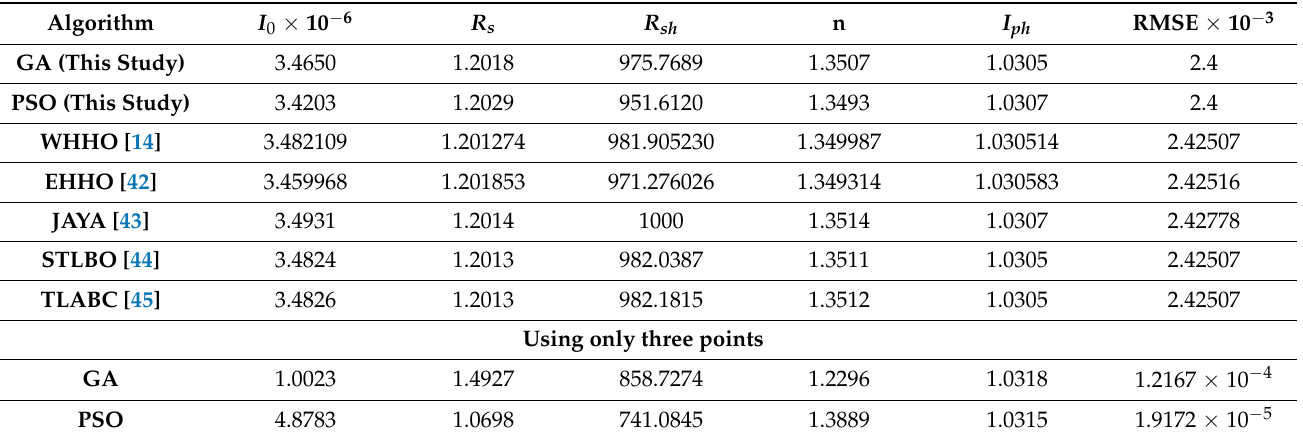
Table 5. Comparison of the proposed methodology and other methods in finding the PWM201 module’s parameters.